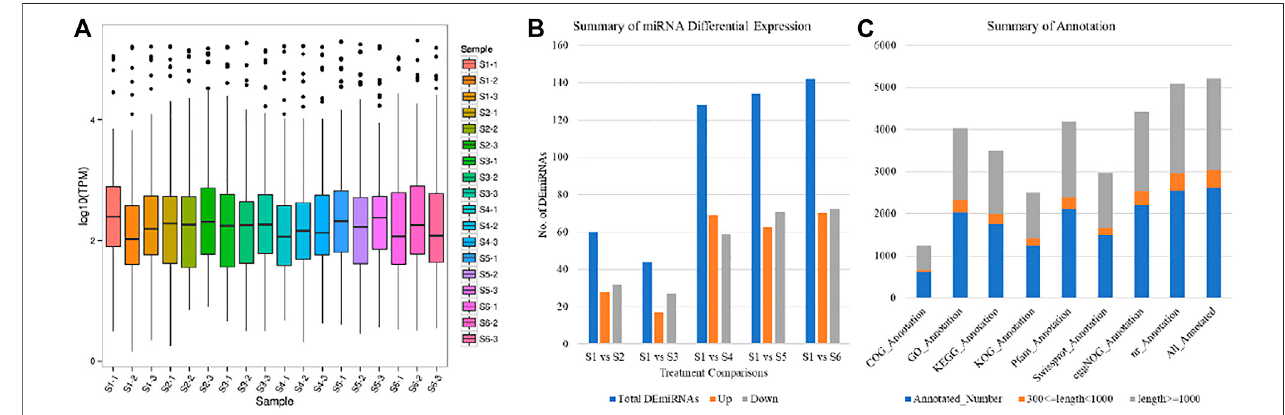
FIGURE 6 | Characterization of miRNAs (A) Overall expression of miRNAs, (B) summary of differentially expressed miRNAs, and (C) annotation summary of the miRNA target genes in taro.